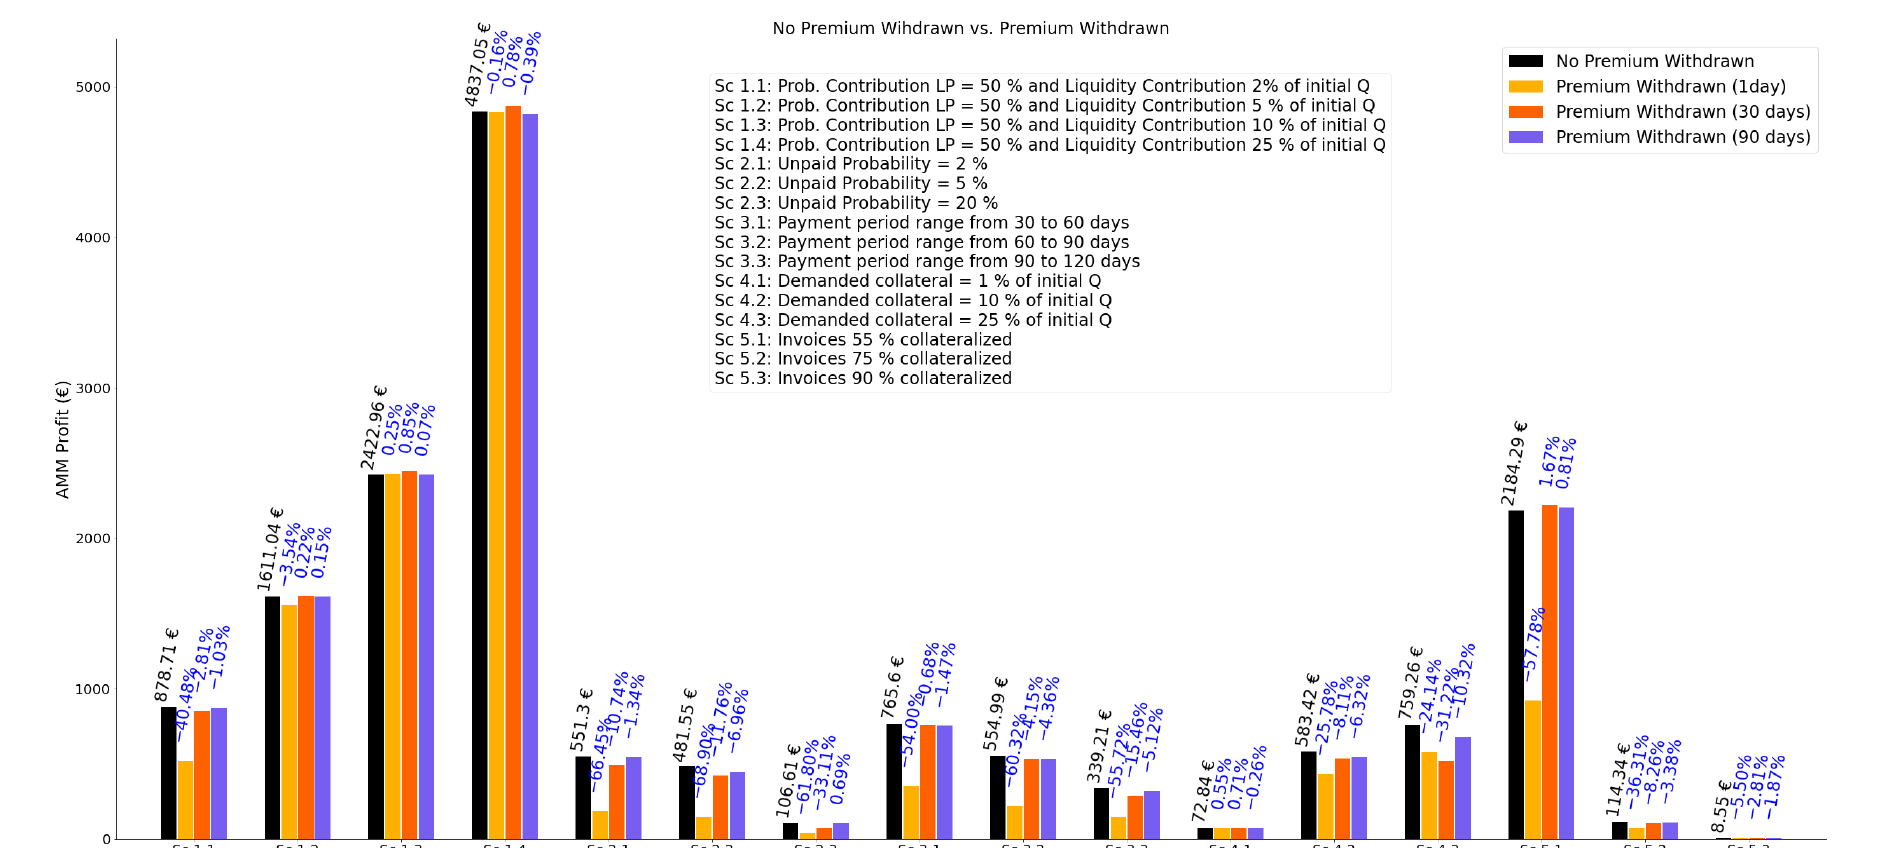
Figure 7. No Premium Withdrawn vs. Premium